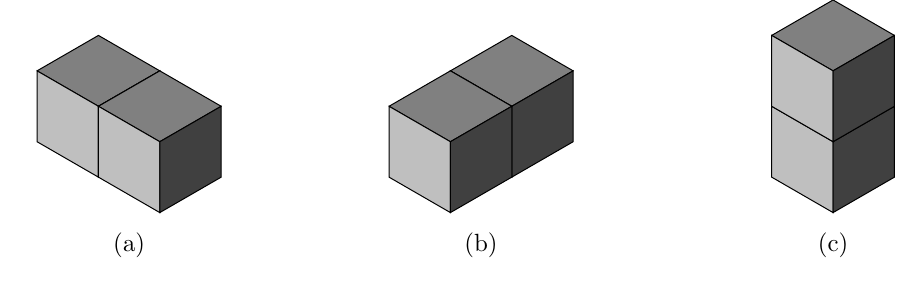
Figure 4. Plane partitions of the case k =